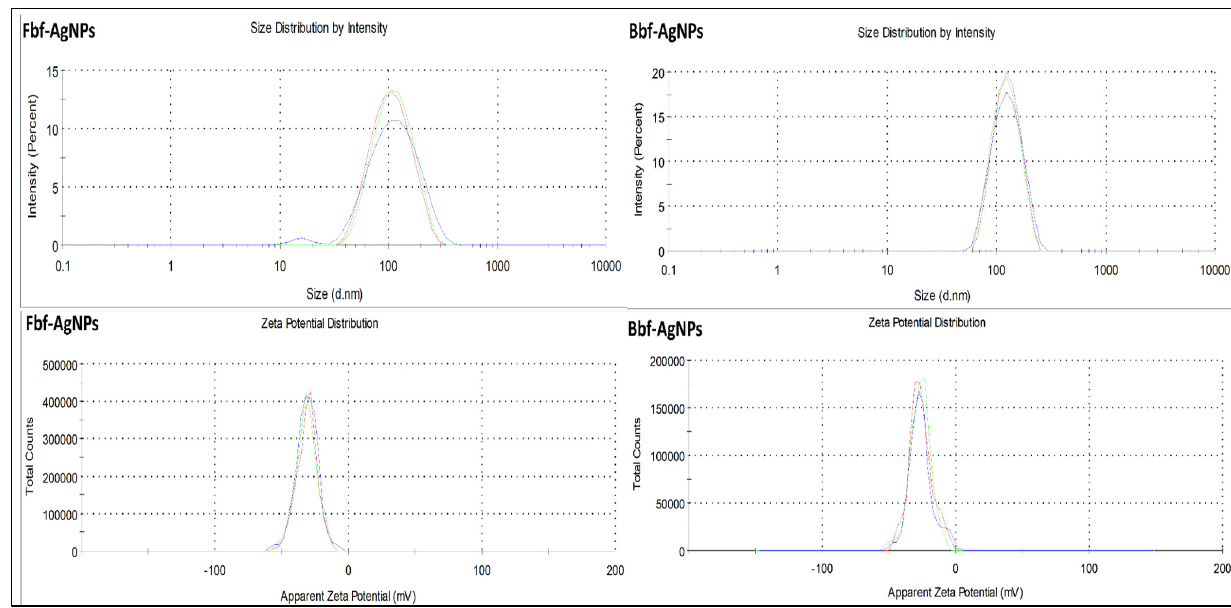
Figure 5. Size distribution and Zeta potential of the biosynthesized Fbf-AgNPs and Bbf-AgNPs.